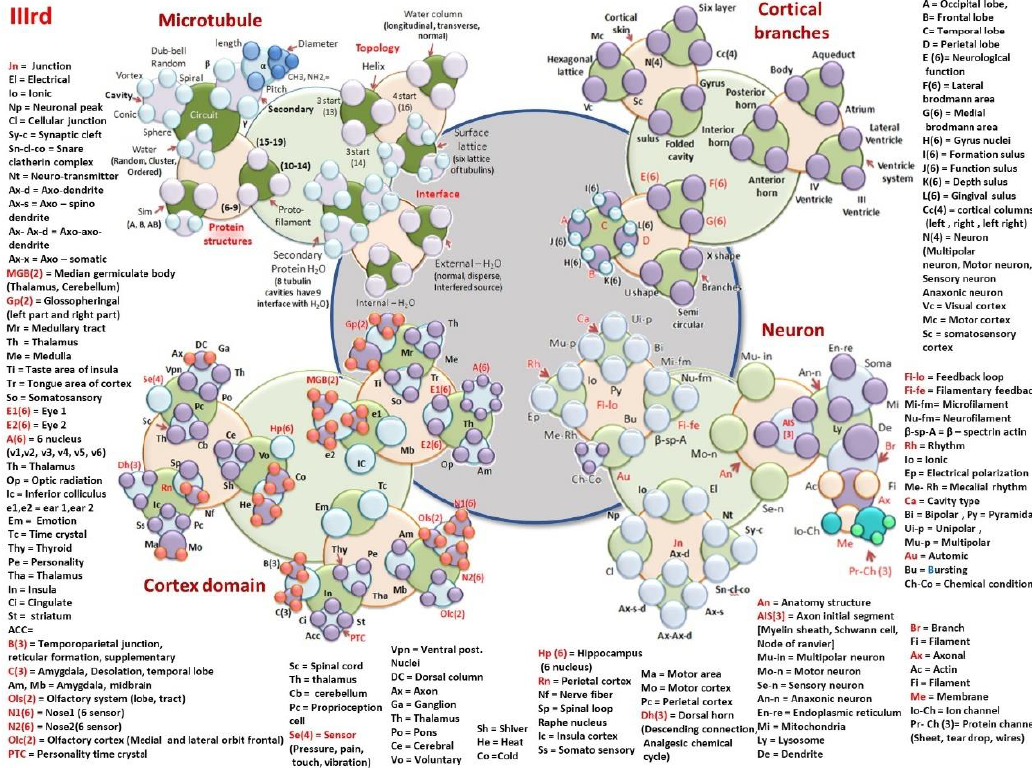
Figure 13. Four brain components. Microtubule, cortical branches, cortex domain and neuron.